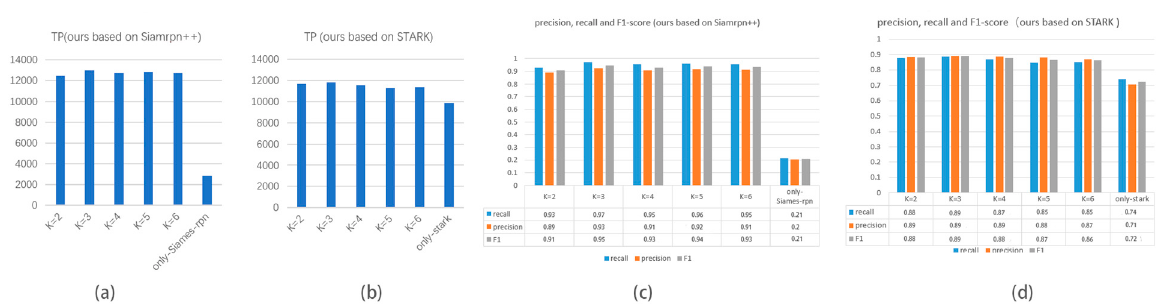
Figure 13. Performances of different models.